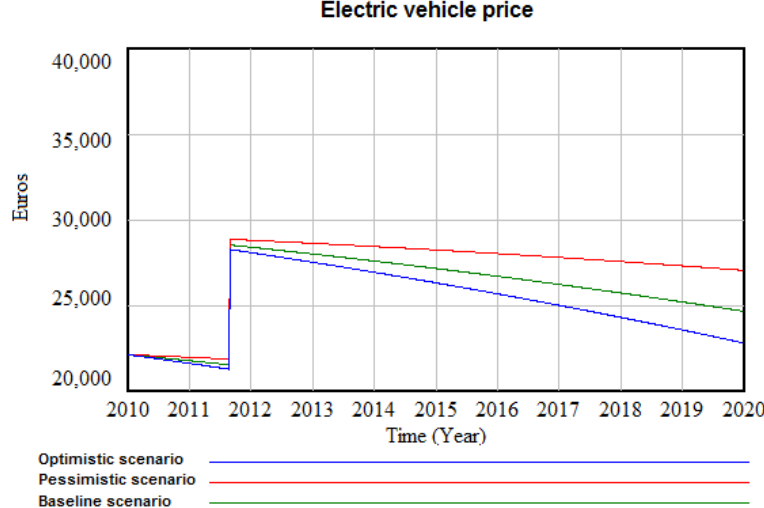
Figure 13. Electric vehicle price for the optimistic, pessimistic and baseline scenarios (own calculations).